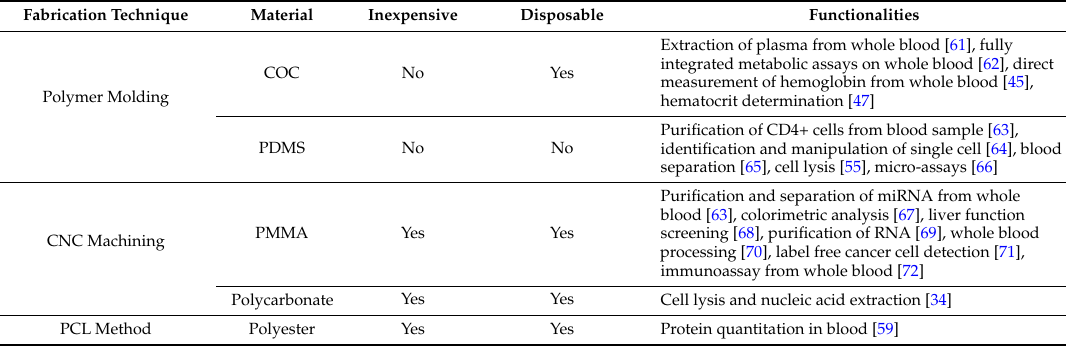
Table 2. Summary of CD manufacturing processes. Only selected examples are